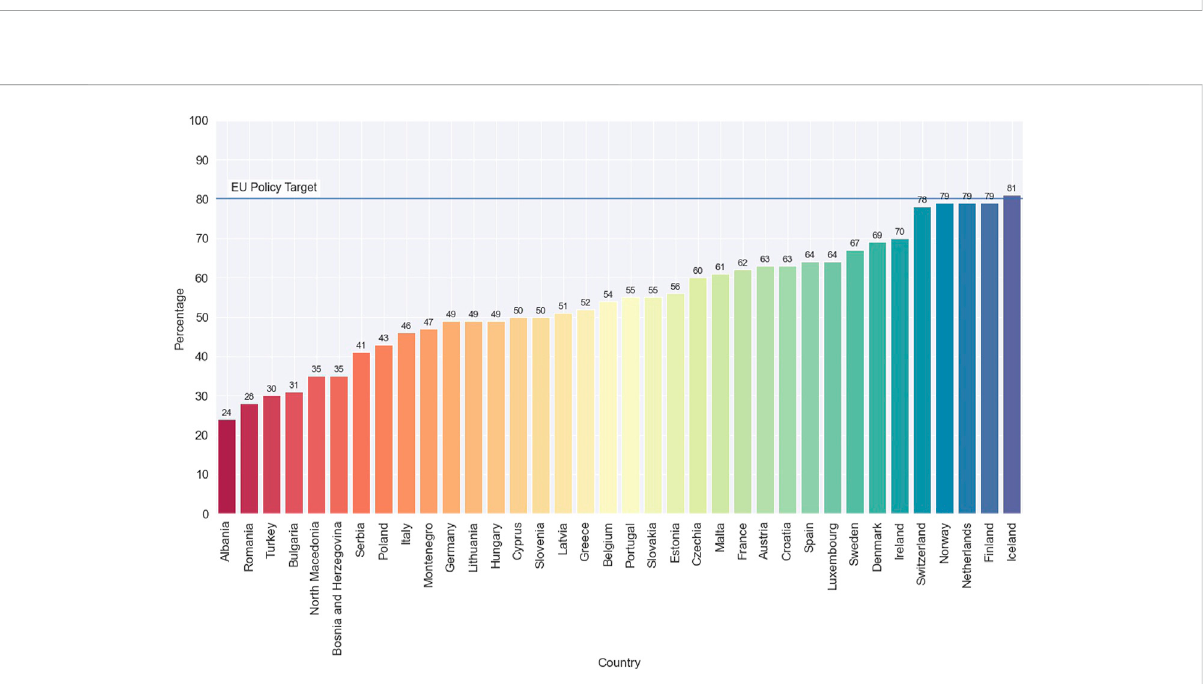
FIGURE 9 Monitoring of an EU SDG indicator across countries in Europe for